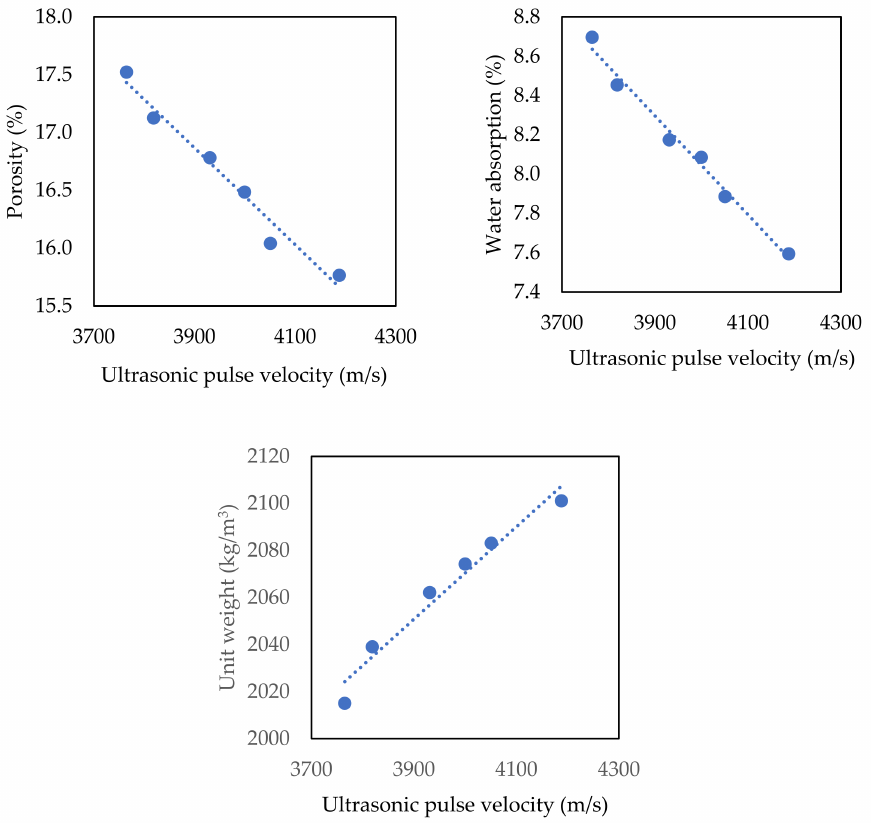
Figure 9. The relationship between the ultrasonic pulse velocity, porosity, water absorption, and unit weight